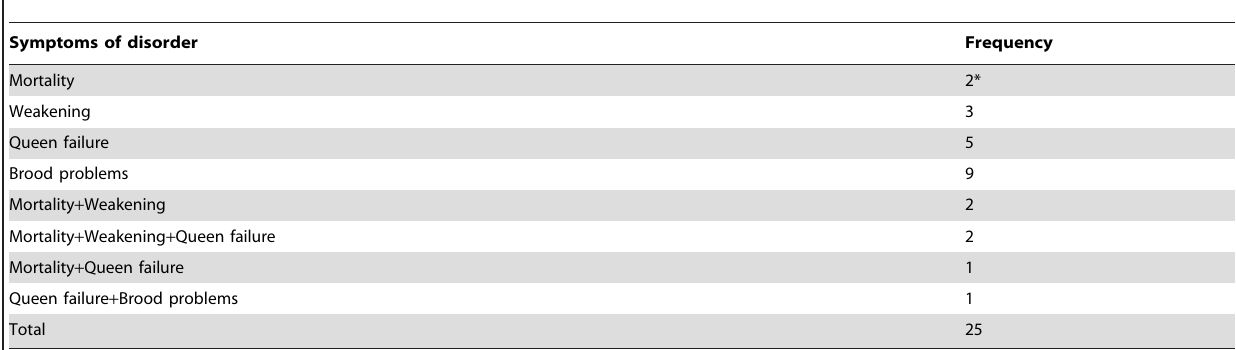
Table 3. Symptoms observed in the group with disorders.